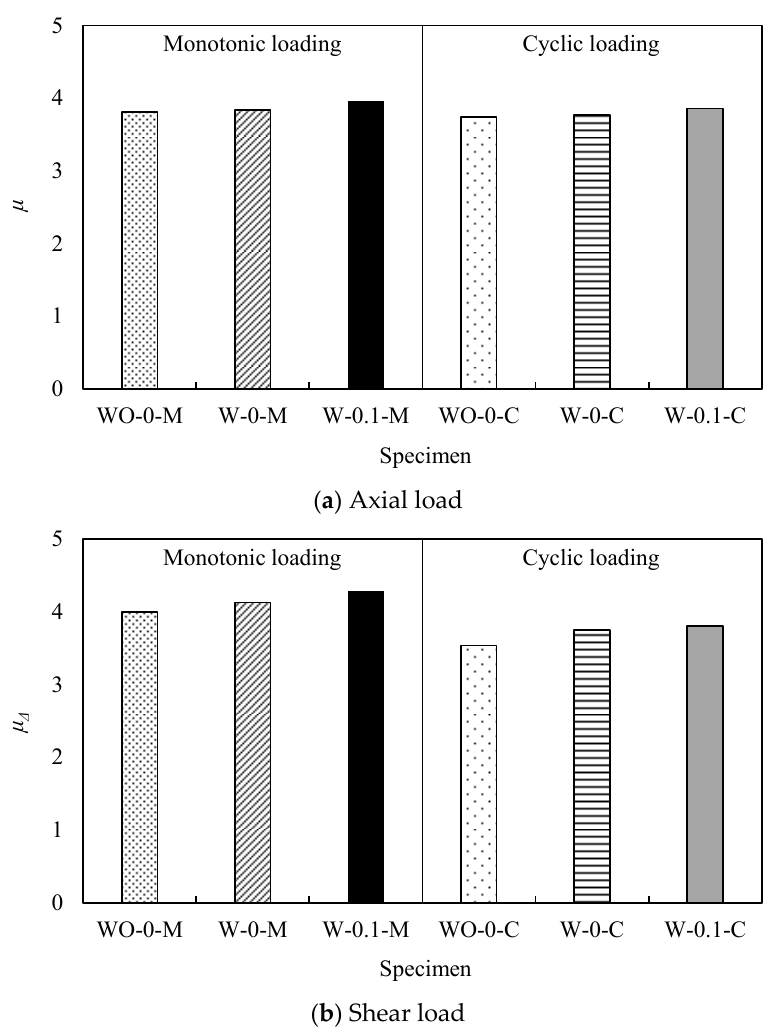
Figure 7. Ductility ratios of the SDI specimens: ( a ) axial load; ( b ) shear load.